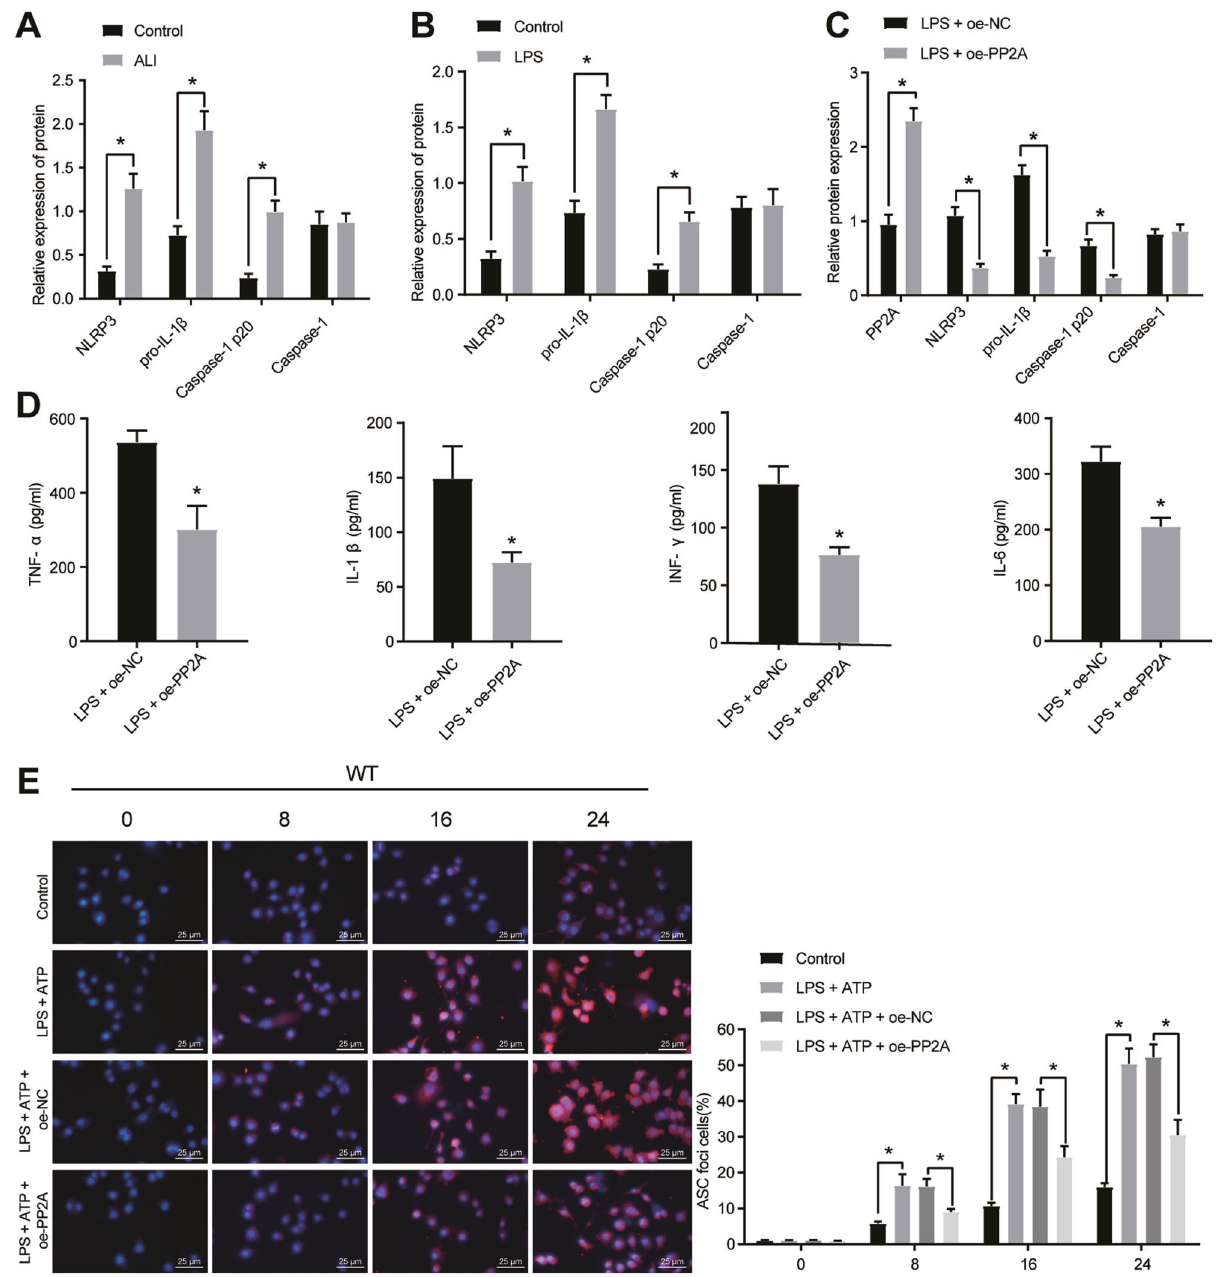
Fig. 4 The inhibitory effect of overexpressed PP2A on LPS-induced cellular in fl ammation and pyroptosis. A The expression of NLRP3 in fl ammasome-related indicators in lung tissues of animal models ( n = 10), detected by western blot analysis. B The expression of NLRP3 in fl ammasome-related indicators in cell models, detected by western blot analysis. C The expression of PP2A and NLRP3 in fl ammasome- related indicators after overexpression of PP2A, detected by western blot analysis. D The levels of lung in fl ammatory factors (TNF- α , IL-1 β , INF- γ and IL-6) after overexpression of PP2A, detected by ELISA. E The formation of pyrosomes, detected by immuno fl uorescence (× 400). * p <